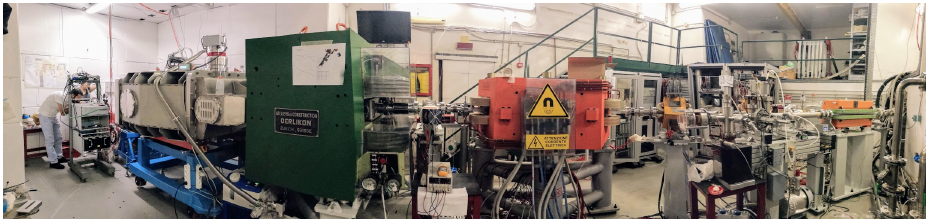
Figure 3. A photograph of the PADME beam line and experimental